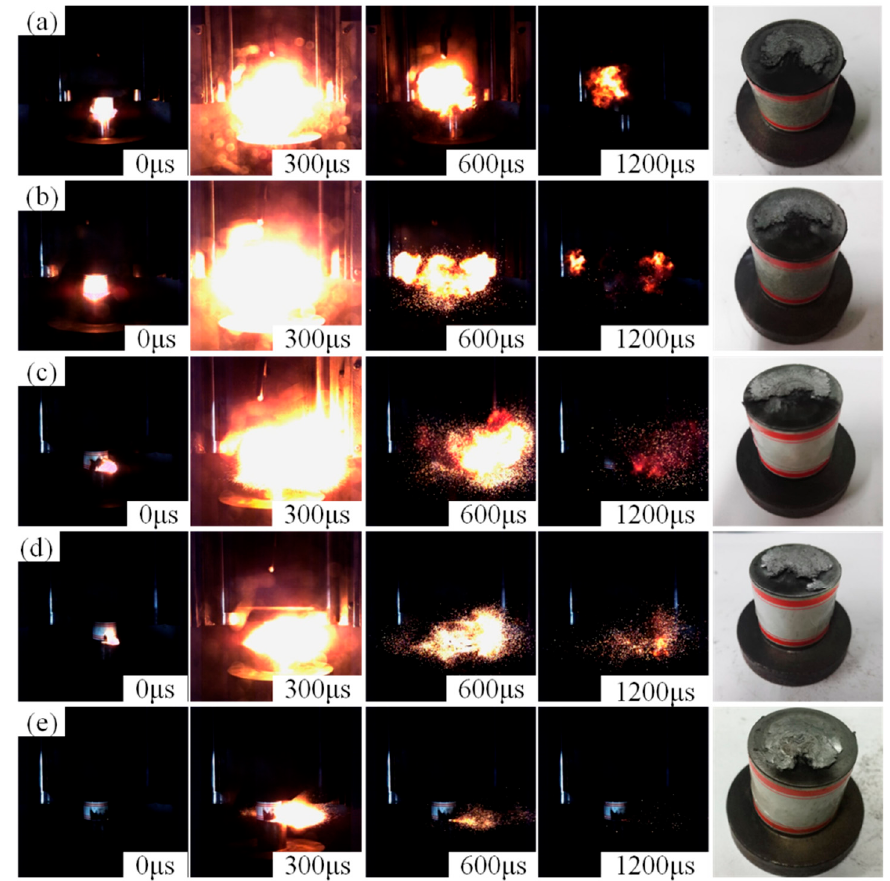
Figure 10. Video sequences of the five PTFE/Al/TiH 2 composites under drop-weight impact at a height of 90 cm, and corresponding sample residues after the tests: ( a ) type A specimens; ( b ) type B specimens; ( c ) type C specimens; ( d ) type D specimens; and ( e ) type E specimens.